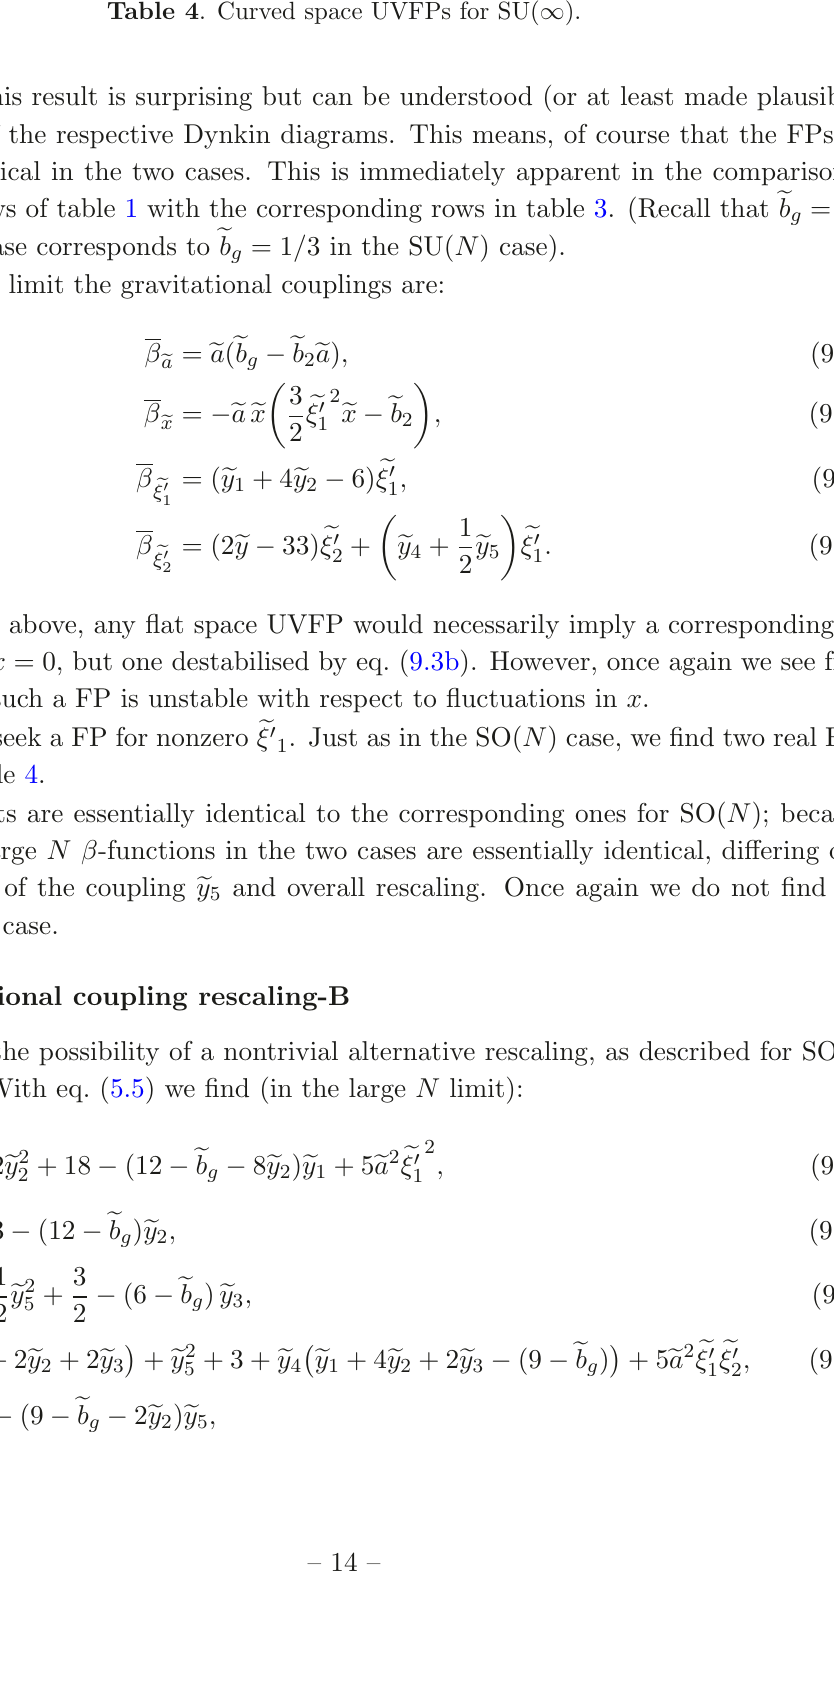
Table 4 . Curved space UVFPs for SU(